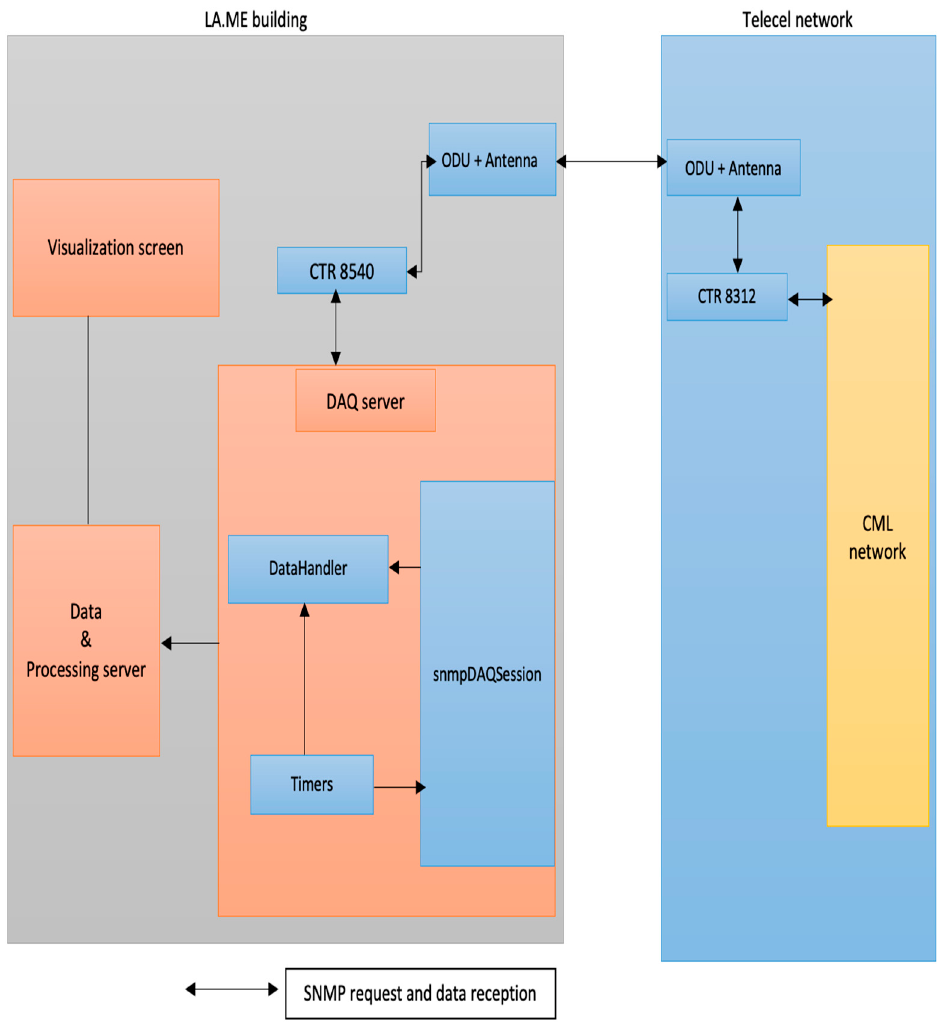
Figure 5. Software structure of the data acquisition system .